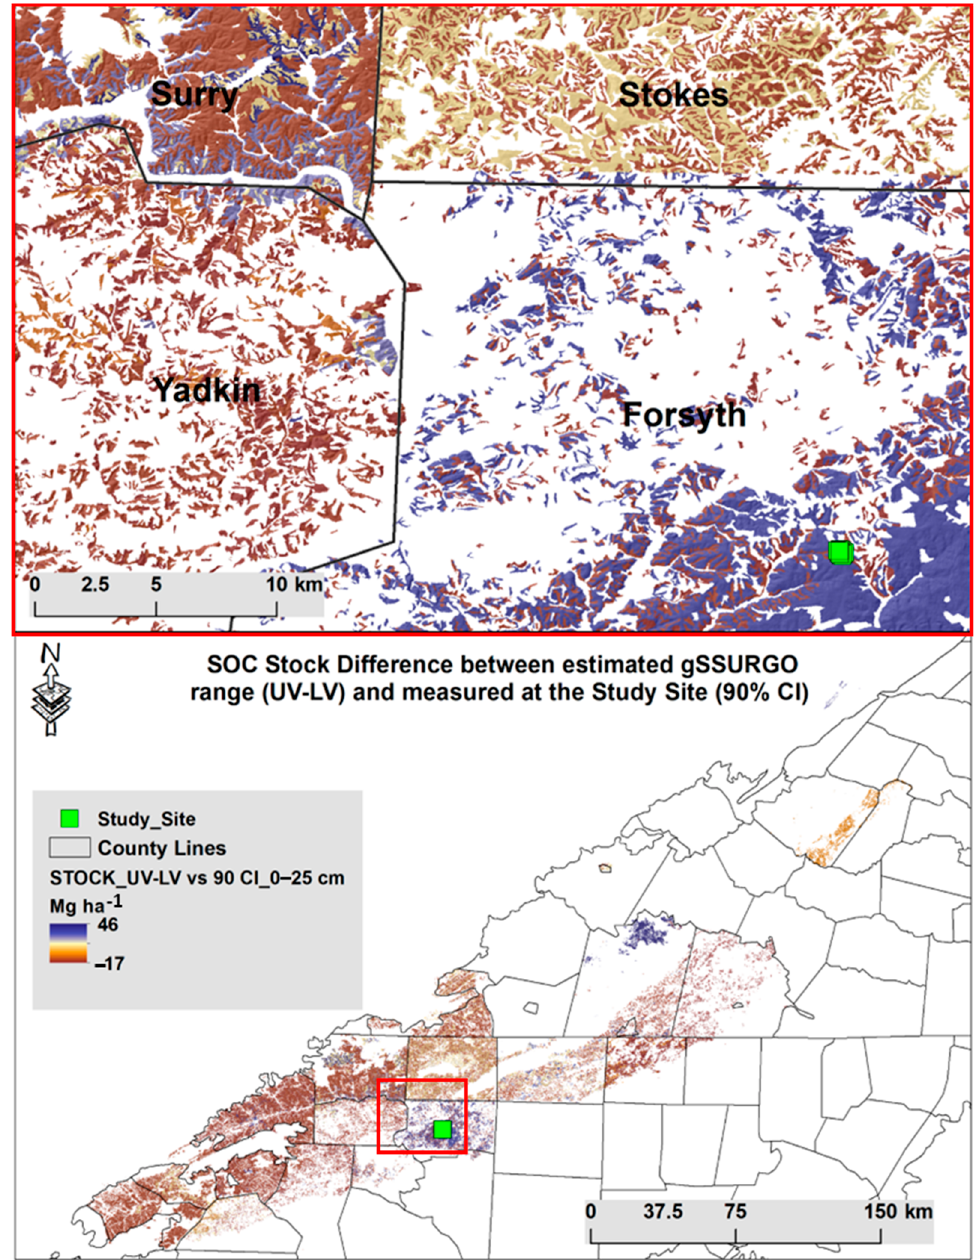
Figure 9. Spatial distribution of SOC stock difference between the estimated gSSURGO range (UV-LV) and the calculated range (90% CI) at the study site based on the measured values for the Fairview series. The upper panel offers a closer look at the contrast between the administrative boundaries and the difference between the two measures of the CI (UV-LV-estimated CI versus 90% CI from measured values for 0–25 cm soil thickness.